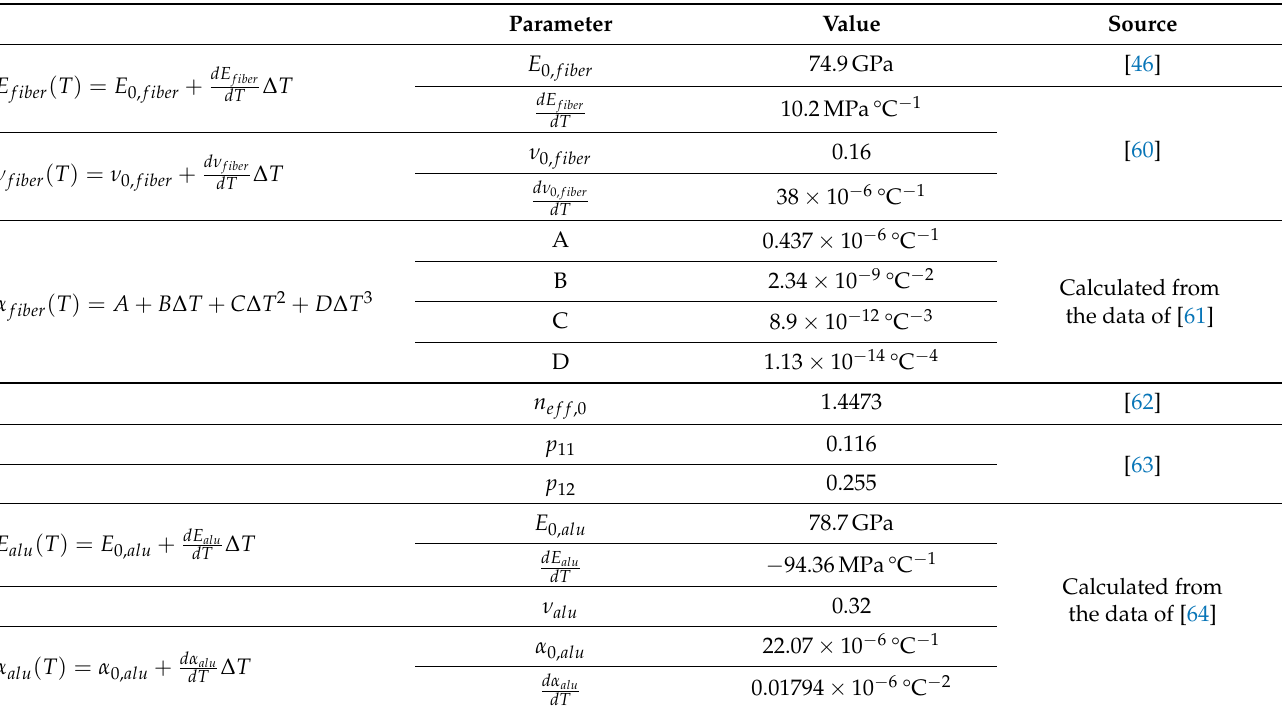
Figure 1. Radial stress as a function of the radial position for fibers with radii a = 62.5µm (grey line) and a = 125µm (red line), which are embedded in a cylindrical part made of aluminum during casting. Table 1. Mechanical and optical parameters ( ∆ T = T − T 0 , T 0 =